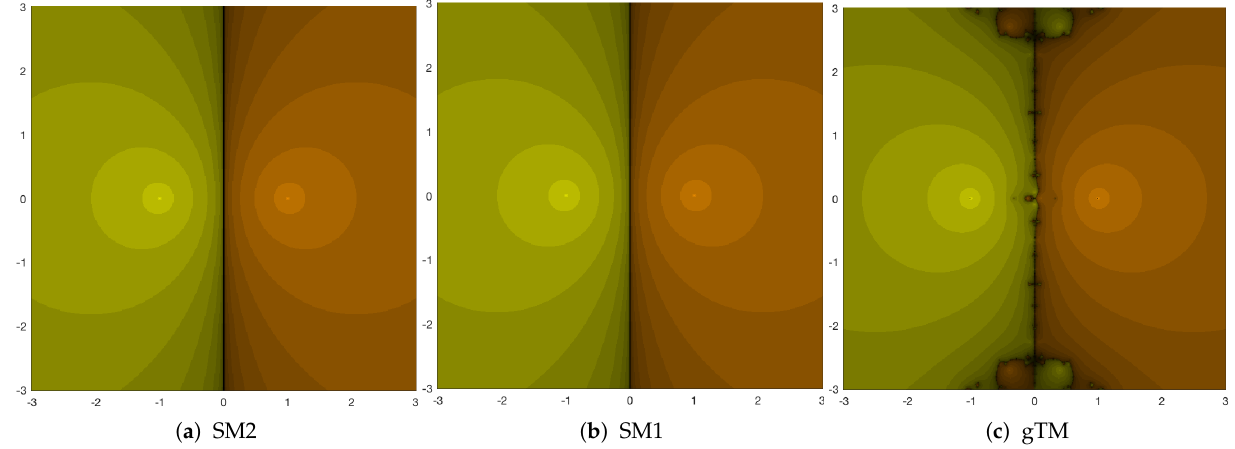
Figure 3. Dynamical planes of Schröder methods and gTM on f 1 ( x ) .